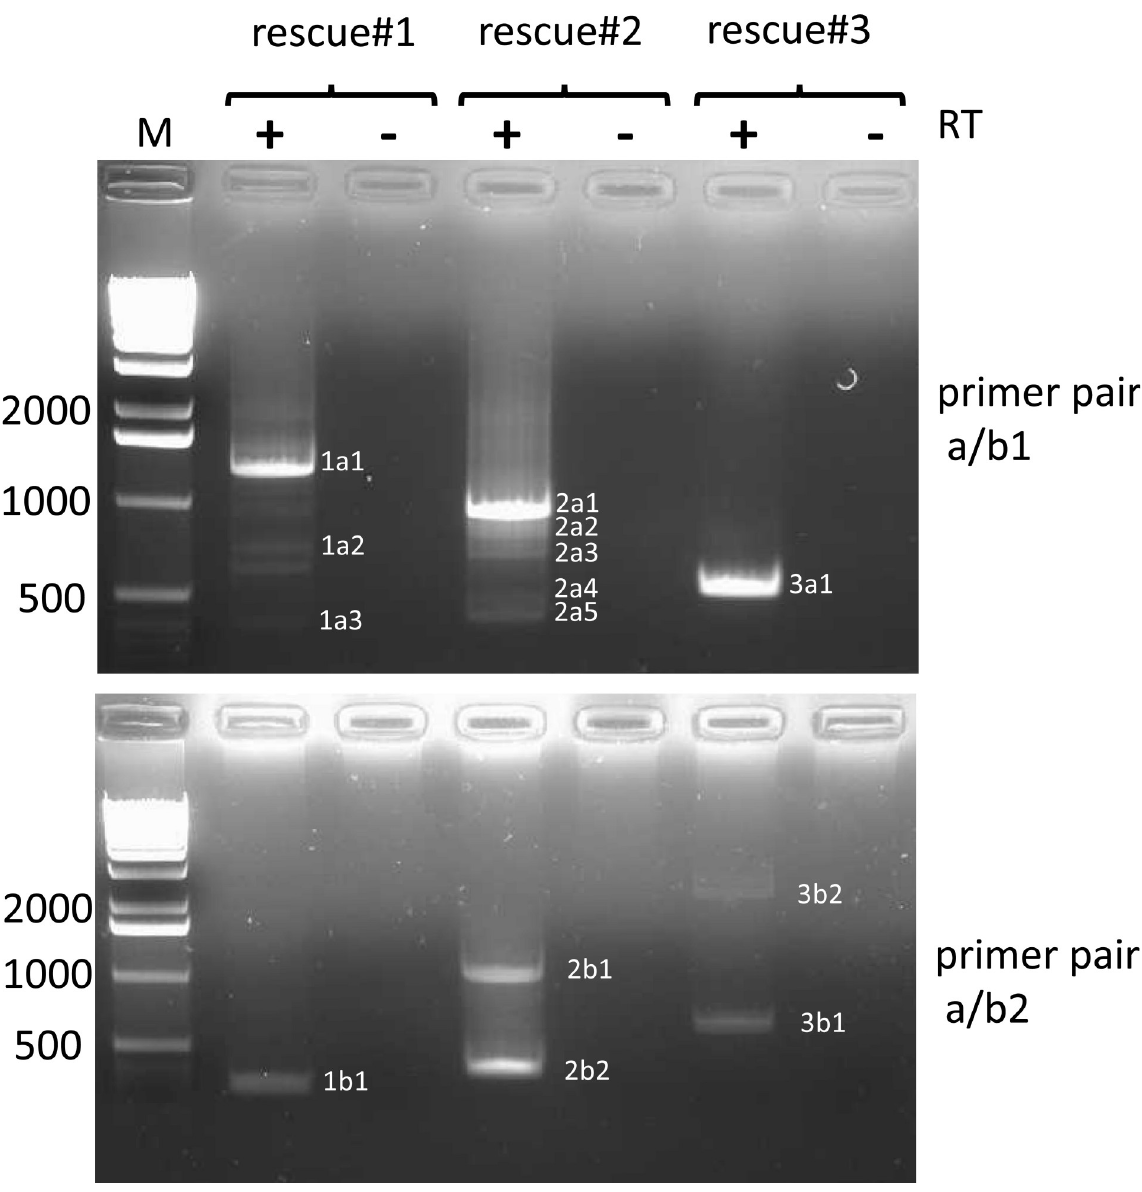
Fig 8. Identification of trailer copyback DVGs in viruses #1, #2 and #3 by RT-PCR. RNA extracted from viruses #1, #2 and #3 was reverse transcribed using primer a and cDNA was amplified with primer pairs a/b1 (upper panel) or a/b2 (lower panel) as outlined in material and methods. Controls (-) were treated the same way except for omission of the RT enzyme. PCR products were analyzed on 1.5% ethidium bromide stained agarose gels. Fragments that were excised from the gels are indicated with numbers. Numbers on the left indicate length of the size markers in nucleotides. (1 kb DNA ladder, Invitrogen / Thermo Fisher).